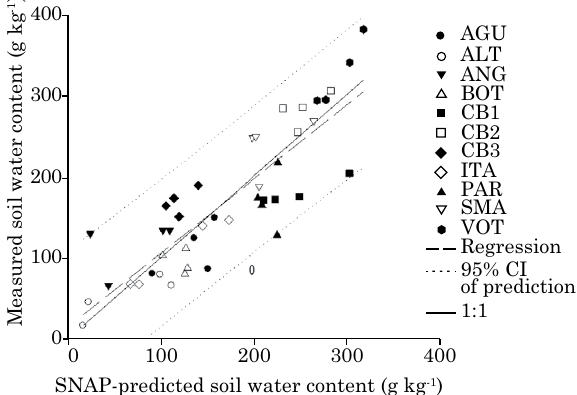
figure 3. soil water - measured (three-monthly on initial core soil samples) versus the predicted daily value [ŷ = 14.5 + 0.910 x, R 2 = 0.75, model efficiency (EF) = 0.71].